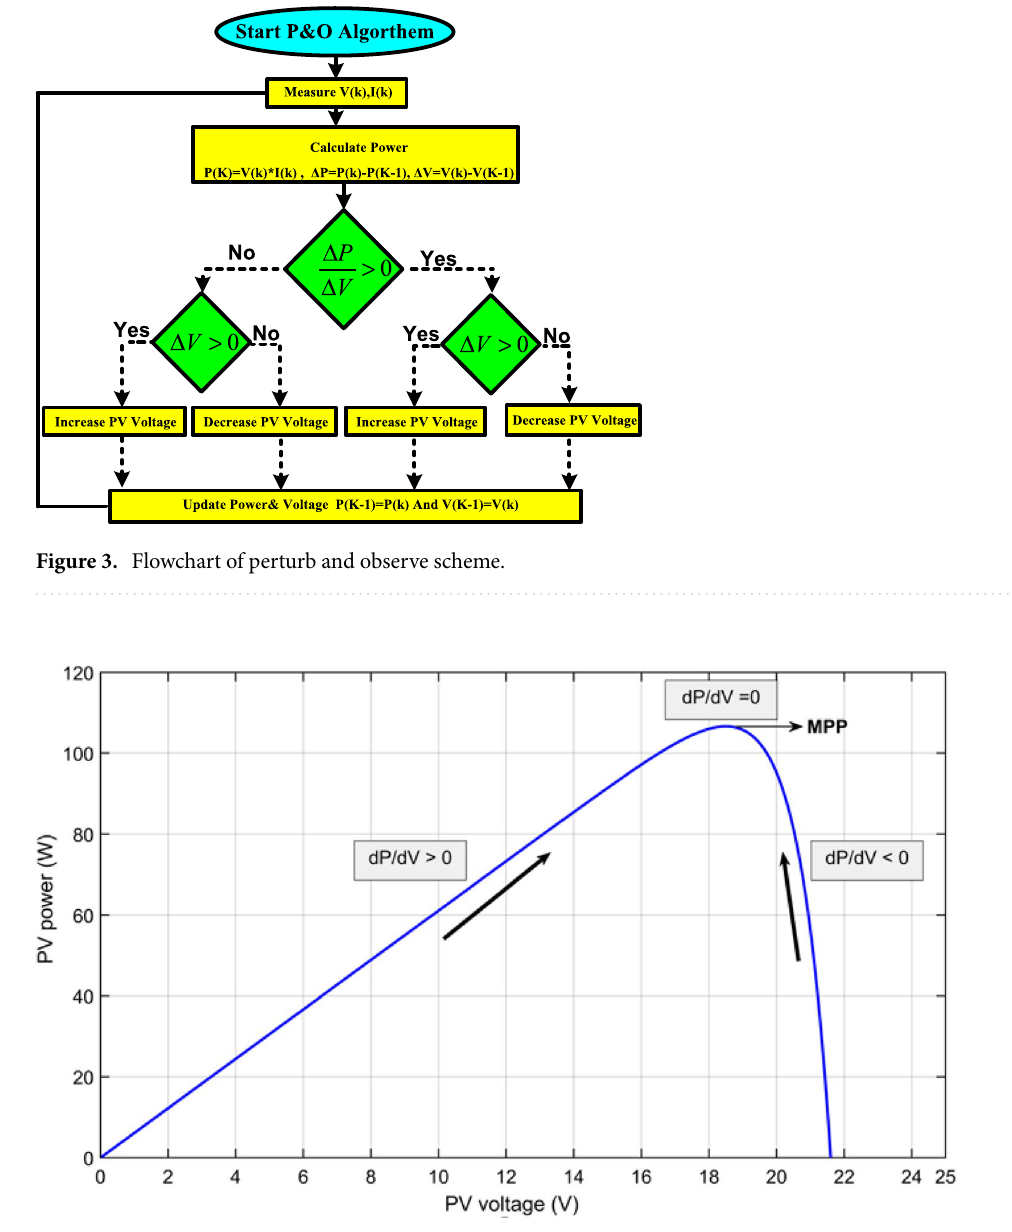
Figure 4. Power against voltage for P&O Algorithm